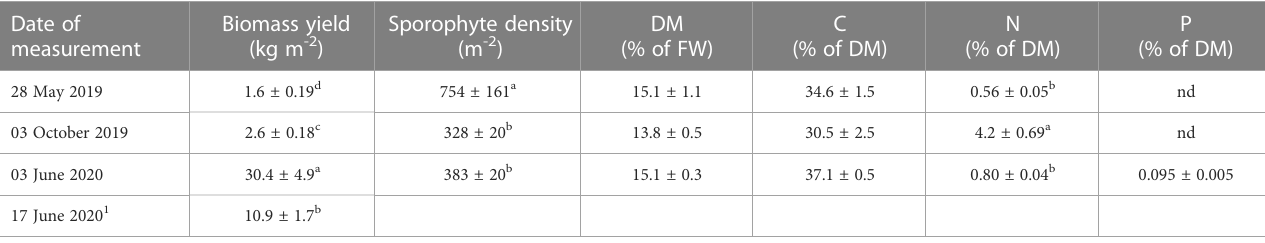
TABLE 3 The biomass yield, tissue content of DM, N and P of the S. latissima growing on the large cultivation net deployed in October